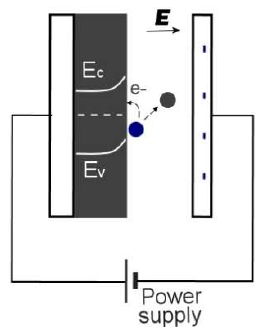
Figure 2. Schematic diagram of the electroadsorptive effect. Adapted from [21].